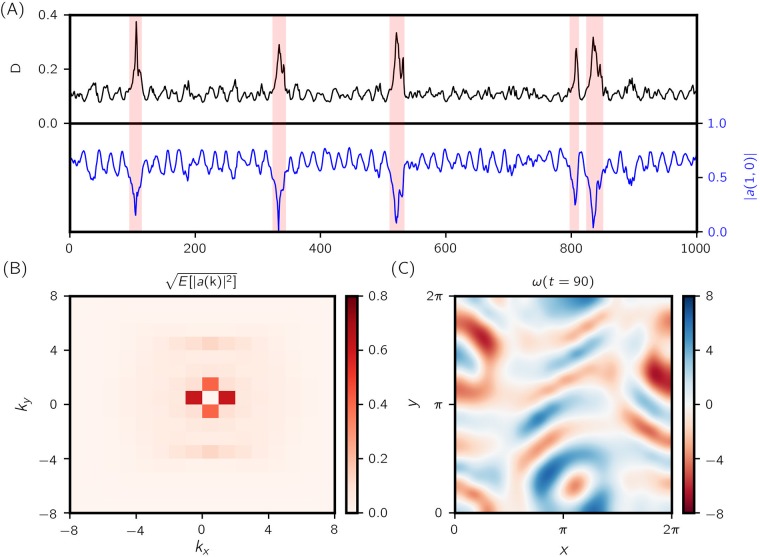
Kolmogorov flow.(A) Time series of energy dissipation rate D and Fourier coefficient modulus |a(1, 0)|—rare events are signaled by burst in D and sudden dip in |a(1, 0)|. (B) Root mean squared (RMS) modulus for wavenumbers −8 ≤ k1, k2 ≤ 8. (C) Vorticity field ∇ × u = ω at time t = 90 over the domain x ∈ [0, 2π] × [0, 2π].